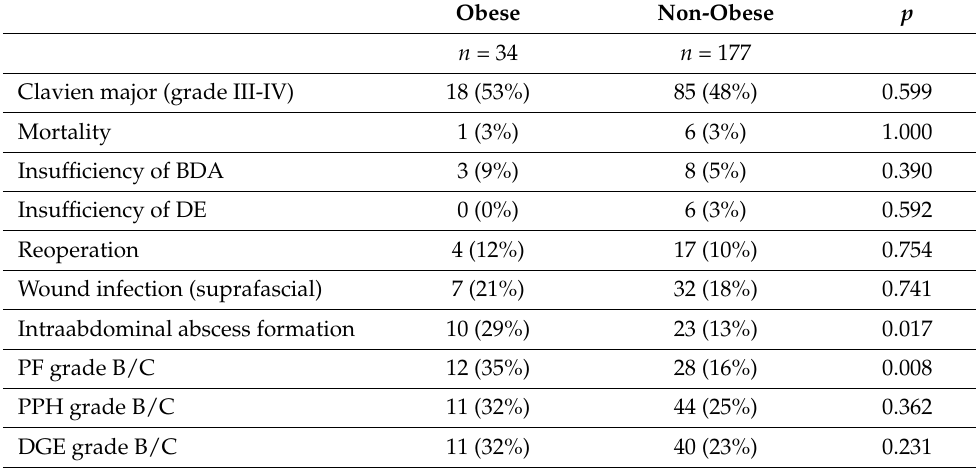
Table 2. Postoperative